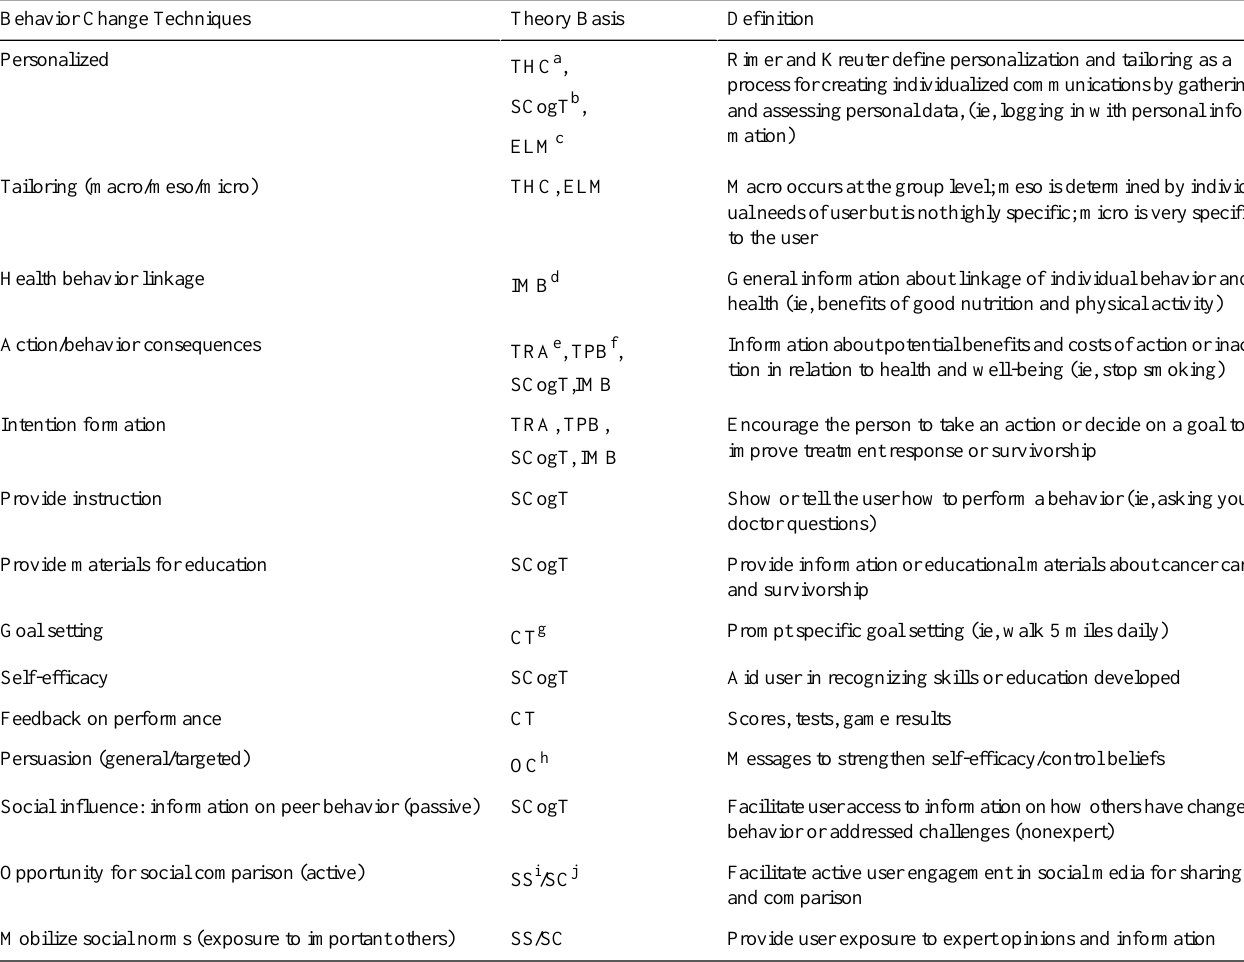
Table 1. mHealth cancer survivorship taxonomy for